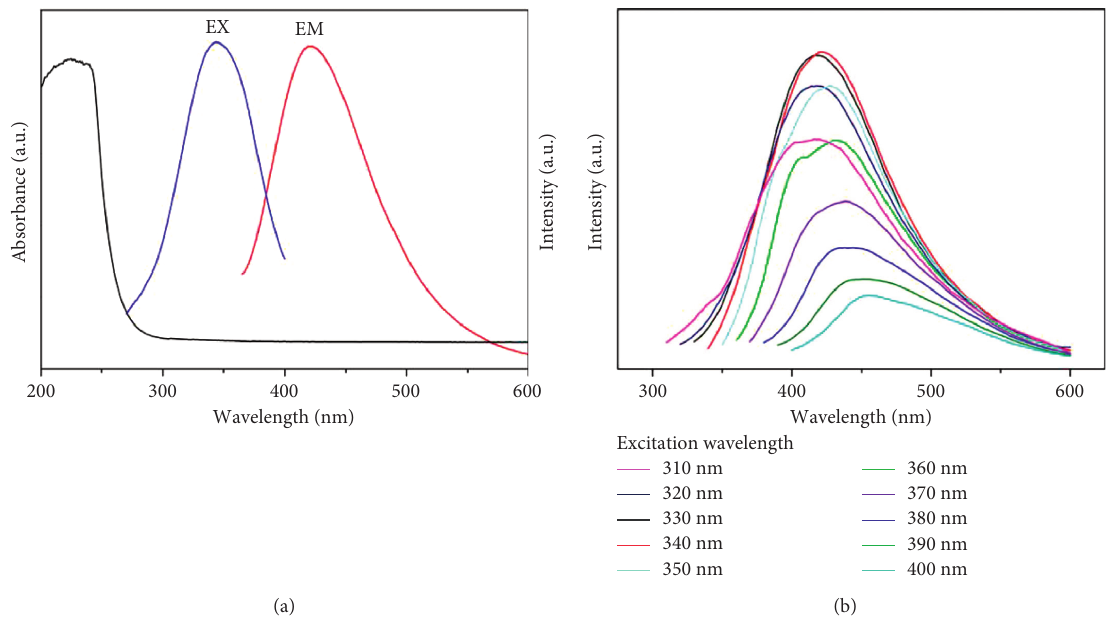
Figure 2: (a) UV absorption spectra and fluorescence excitation (Ex) and emission (Em) spectroscopy. (b) Fluorescence spectra of CDs at different excitation